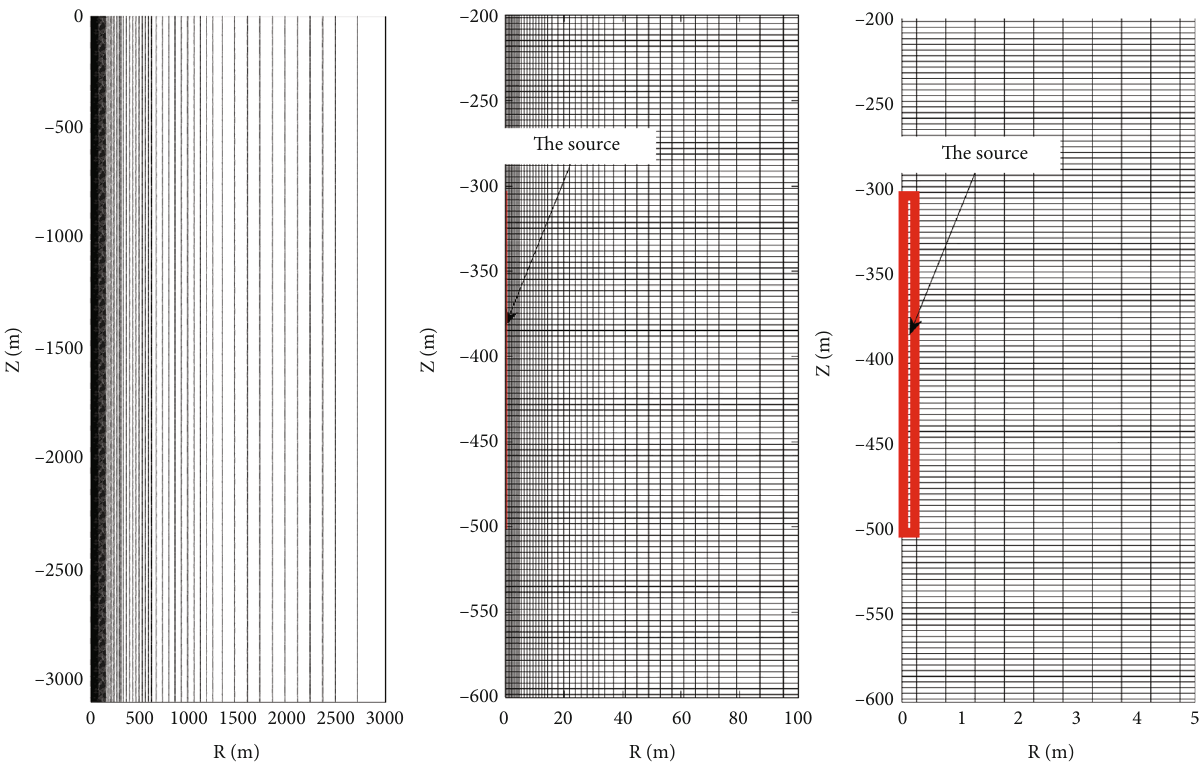
Figure 4: Three views of the structured mesh. (a) shows discretisation across the radial distance; vertical discretisation is not shown. (b) shows discretisation of host rock surrounding the source zone. (c) shows discretisation of the heat and radionuclide source for the shallowest disposal